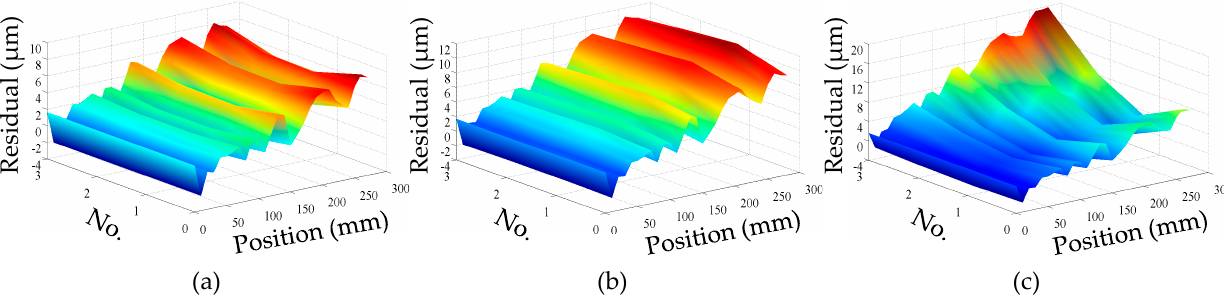
Figure 20. Residual error in experiment II: ( a ) residual error of the PCR model; ( b ) residual error of the MLR model; and ( c ) residual error of the ANN model.